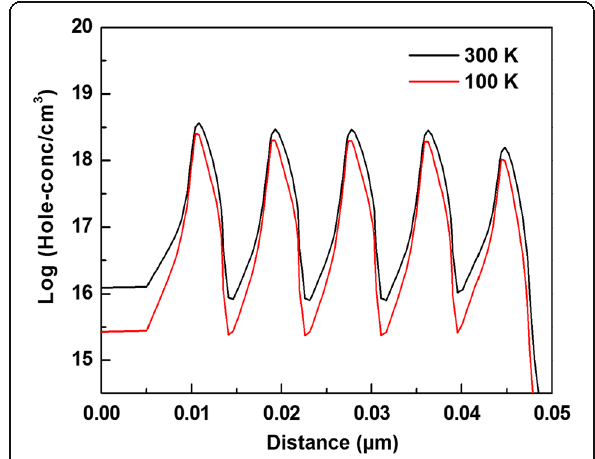
Fig. 4 The hole concentrations in active region at 100 and 300 K